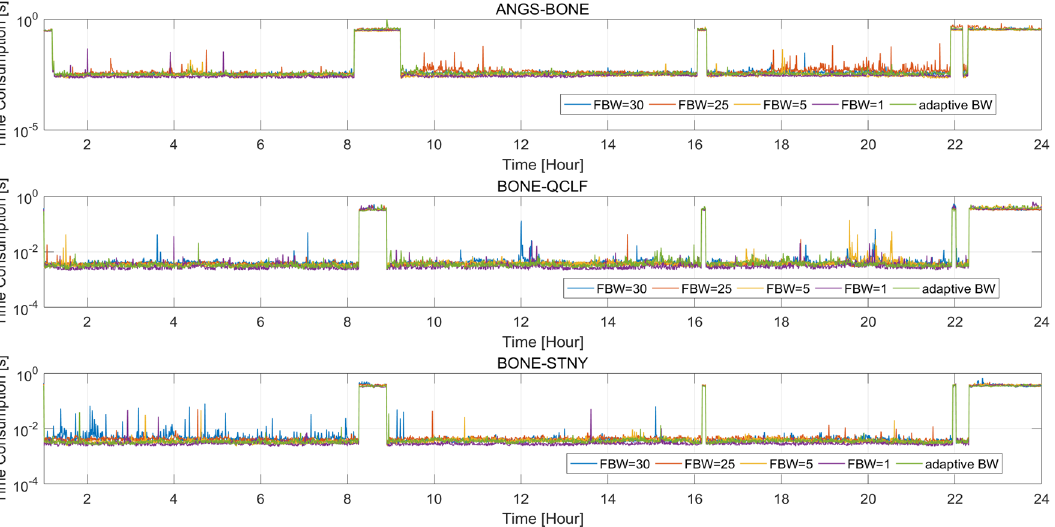
Figure 5. Time consumption with different KBW strategies on ANGS-BONE, BONE-QCLF, BONE-STNY.